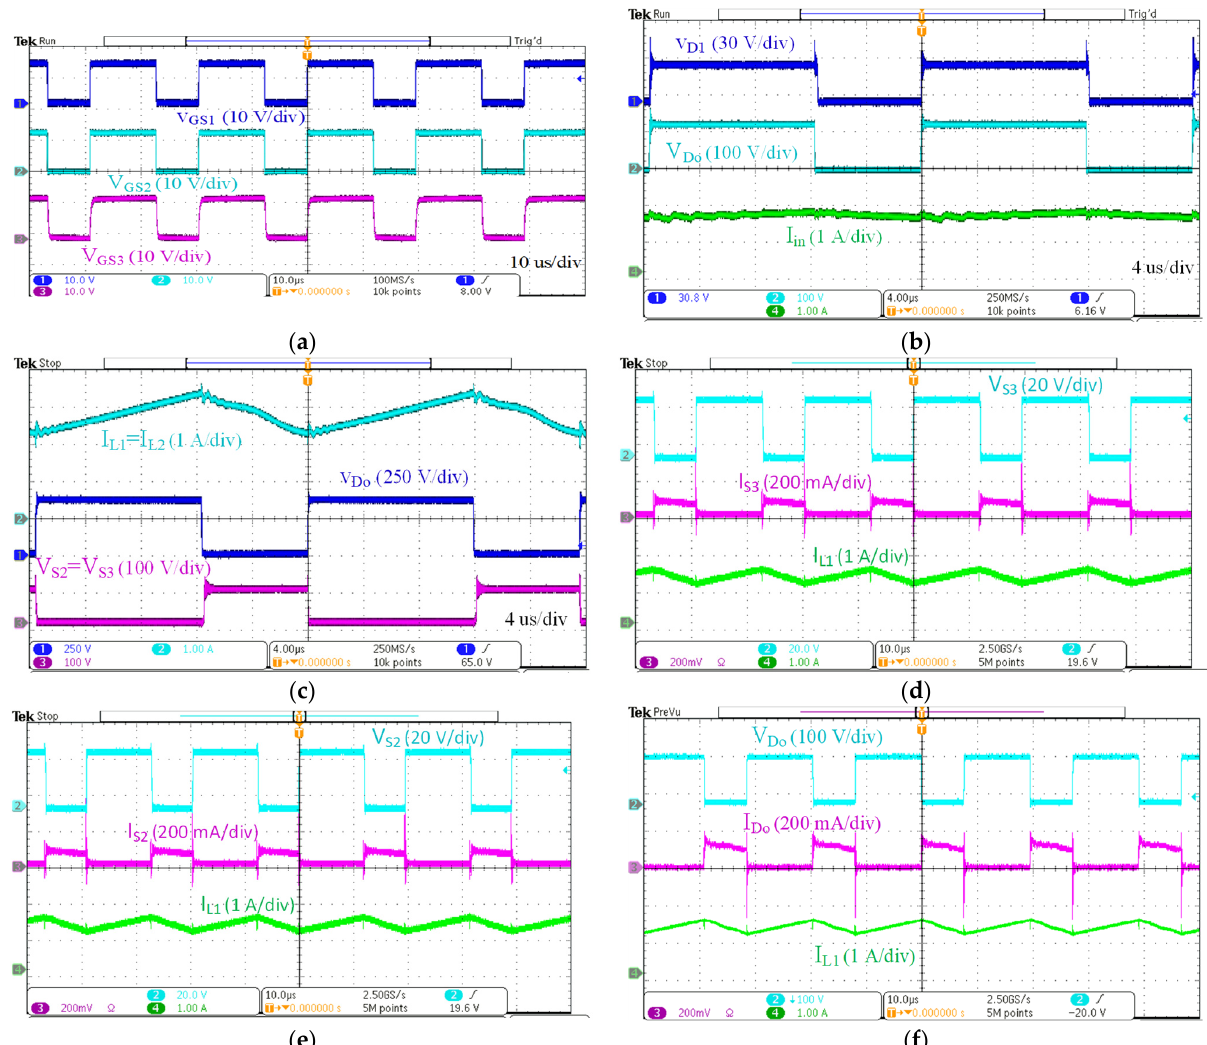
Figure 12. Experimental results of converter at duty cycle of 0.6 and input voltage of 30 V: ( a ) gate source pulses; ( b ) Ch1 diode D 1 voltage, diode D o voltage, and input current; ( c ) Ch1 output diode D o voltage, Ch3 switches’ S 2 and S 3 voltage, and Ch2 inductor L 1 current; ( d ) Ch1 switch S 3 voltage; Ch2 switch S 3 currents; ( e ) Ch2 switch S 2 voltage, Ch3 switch S 2 current, and inductor current; and ( f ) Ch2 diode D o voltage and diode D o current.